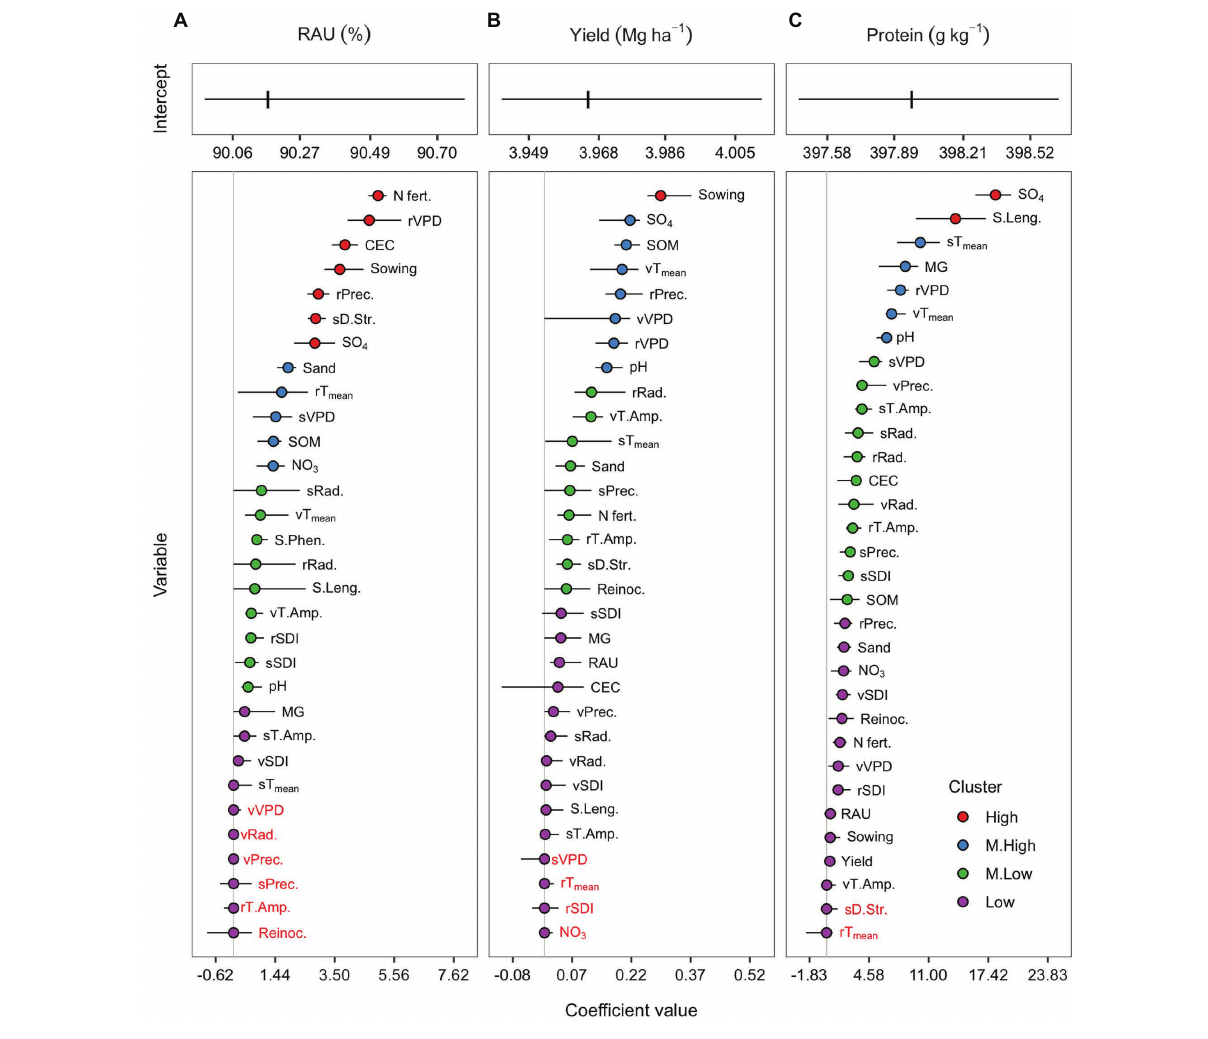
FIGURE 3 | Centered and scaled covariables coefficients of the full model for the RAU (A) , seed yield (B) , and protein concentration (C) . Coefficients were grouped in high (red), medium-high (blue), medium-low (green), and low (purple) magnitude clusters by the k-means algorithm. Coefficients with red letters were shrunk to zero by the elastic net regularization process. Points represent the median from the 20 training-test combinations, while horizontal lines range from the minimum to the maximum coefficient values across